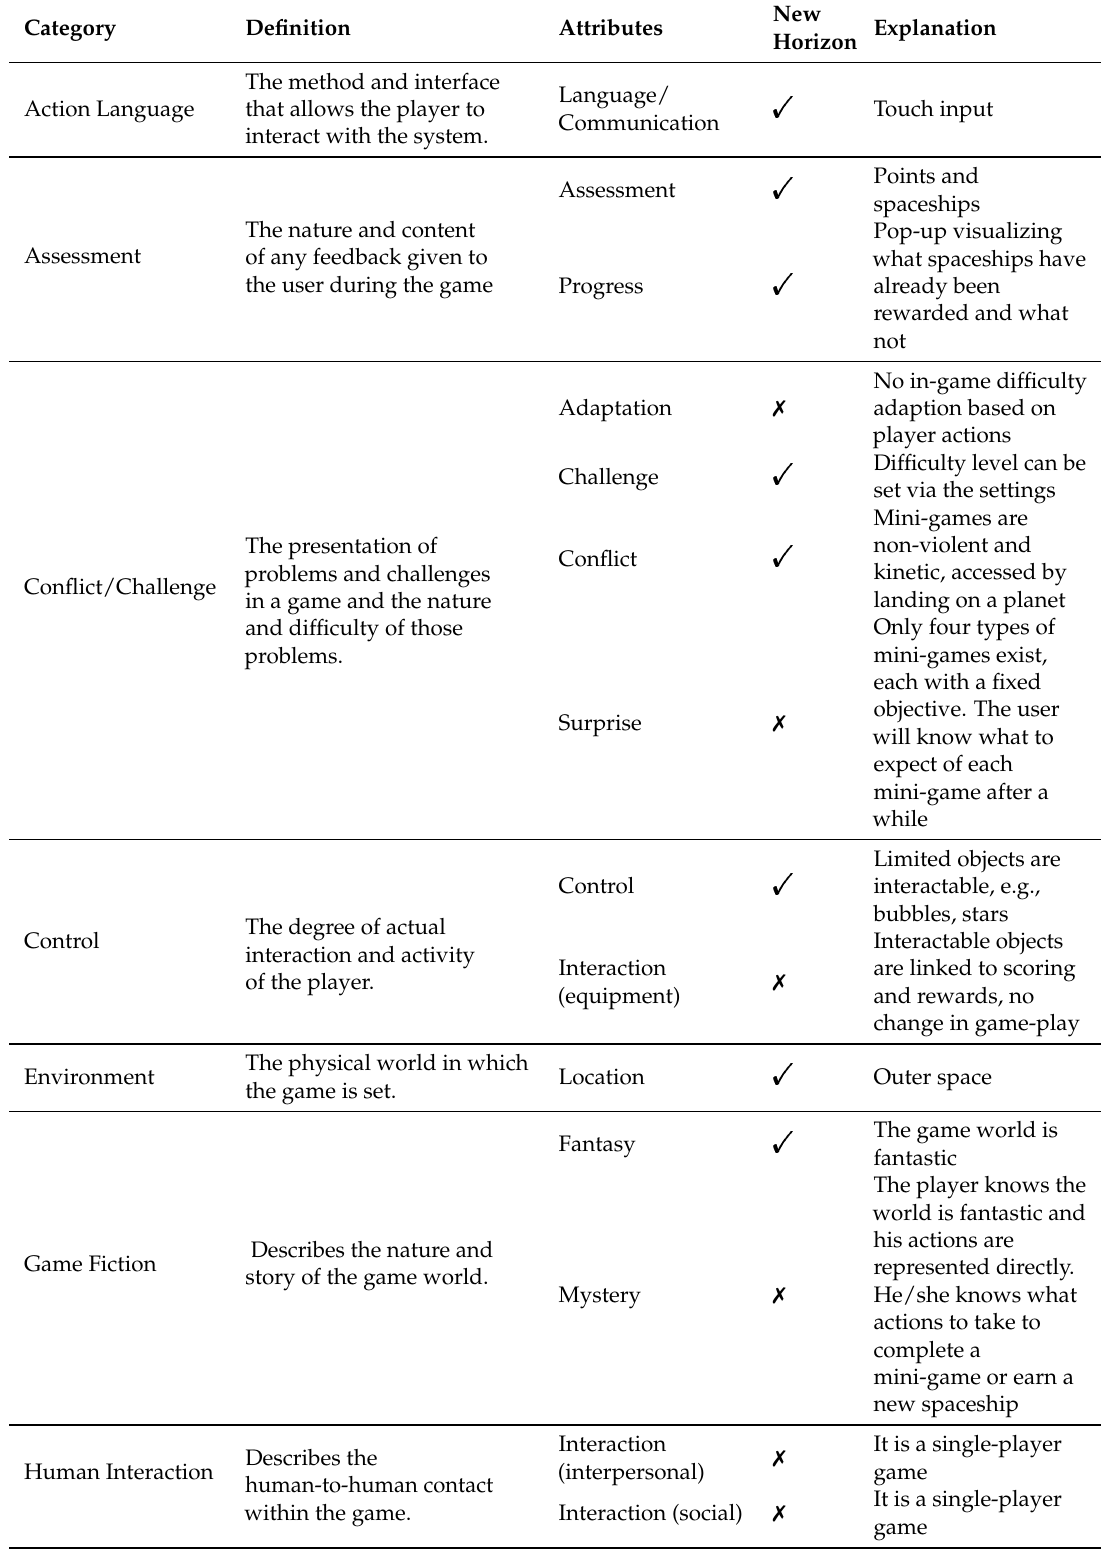
Table 6. Analysis of the game elements integrated in New